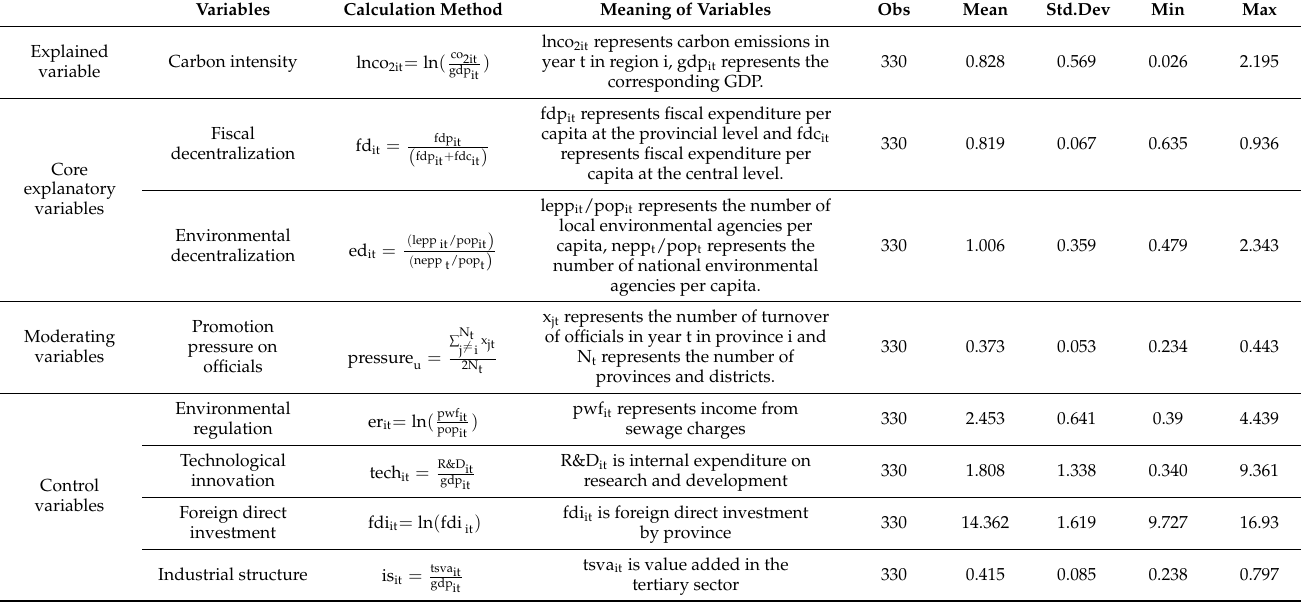
Table 1. Calculation method and descriptive statistics for each